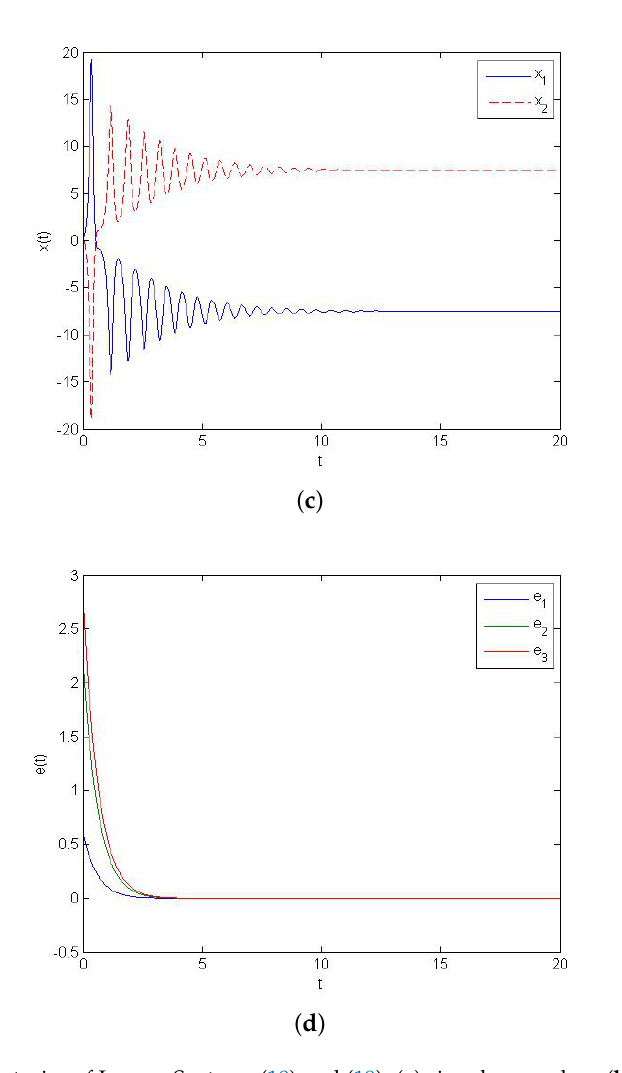
Figure 1. State trajectories of Lorenz Systems (18) and (19): ( a ) signals x 1 and x 2 ; ( b ) signals y 1 and y 2 ; ( c ) signals z 1 and z 2 ; ( d ) state trajectories of the error signals e 1 , e 2 , e 3 .